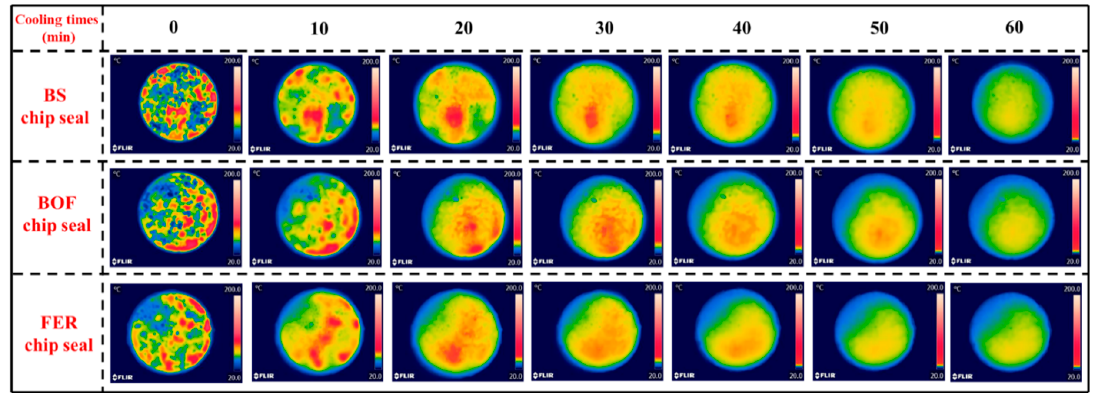
Figure 7. Infrared images of chip seal samples during cooling process.